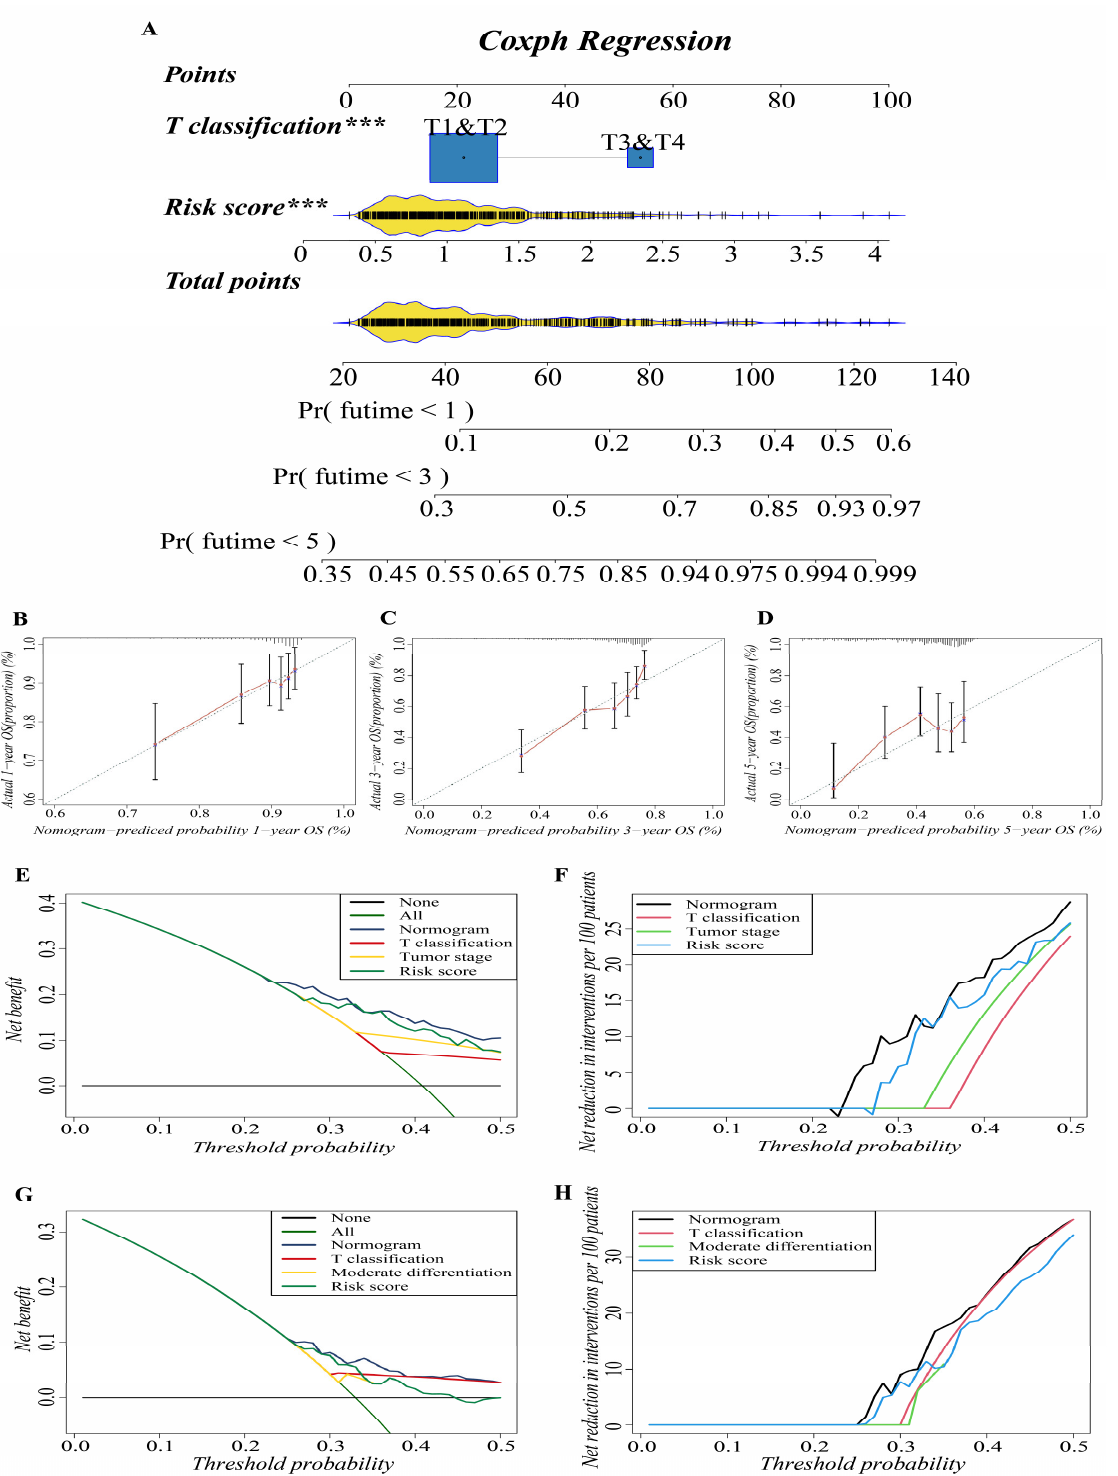
Figure 4. Construction and validation of the predictive nomogram. ( A ) The nomogram for OS prediction at 1, 3 and 5 years was constructed in the training cohort. A value of p < 0.05 indicates a statistically significant difference, *** indicates p < 0.001. ( B – D ) Calibration plots of the nomogram for OS prediction at 1, 3 and 5 years in the training cohort, respectively. ( E , G ) Net decision curve analyses demonstrating the benefit of predicting LUAD patients’ prognosis (( E ): training cohort; ( G ): validation cohort). ( F , H ) The net reduction analyses based on nomogram model and other models (( F ): training cohort; ( H ): validation